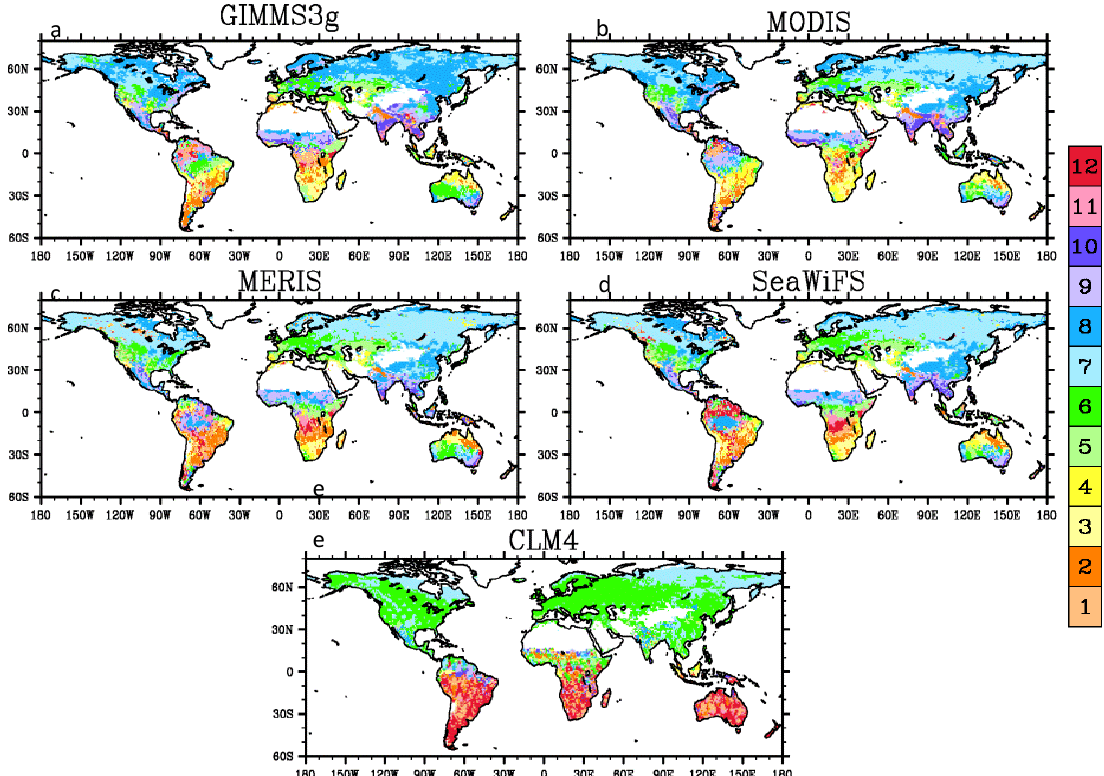
Figure 8. Comparison of month of maximum FPAR between RS observations and CLM4 FPAR averaged from 2003 to 2005, ( a ) GIMMS3g, ( b ) MODIS, ( c ) MERIS, ( d ) SeaWiFS, and ( e ) CLM4 simulation.